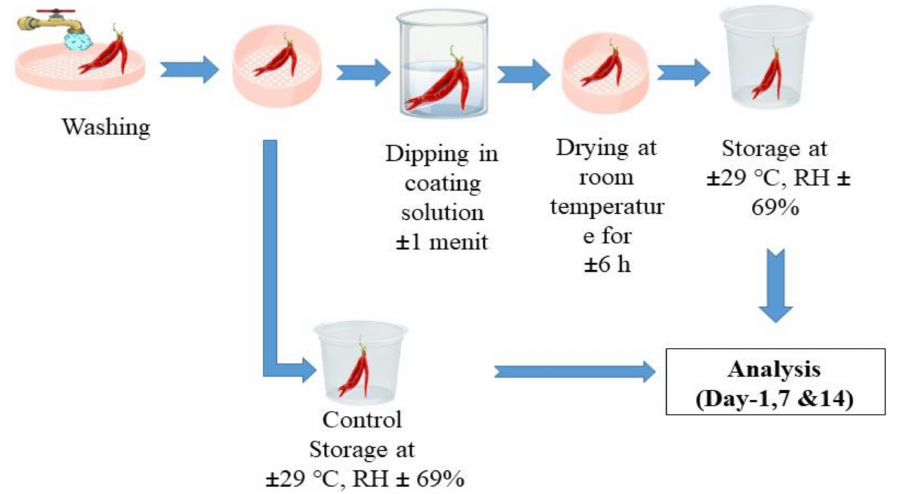
Figure 9. Application of edible coating on red